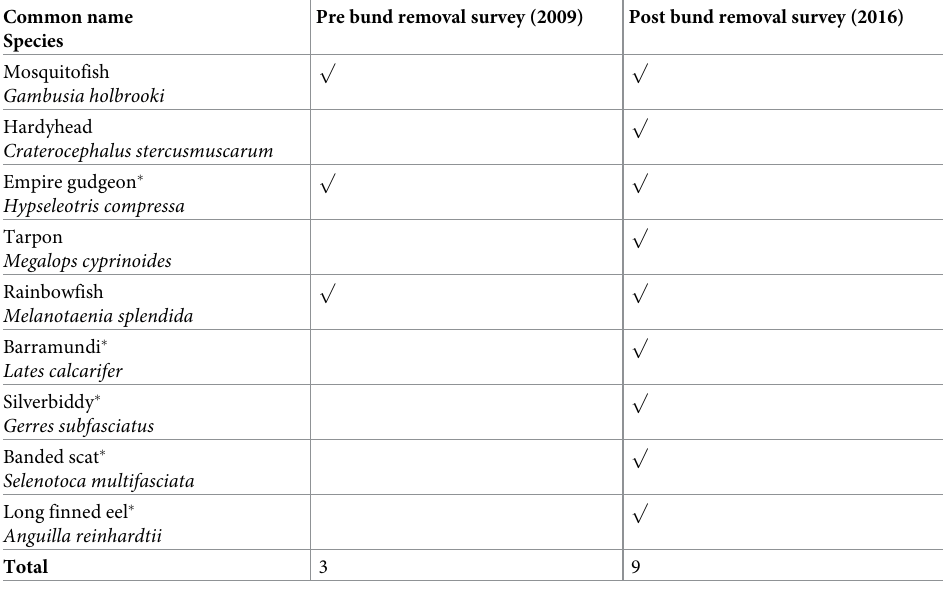
Table 4. Fish community composition in the Mungalla wetland (Boolgooroo) before bund removal in 2009 and following removal in